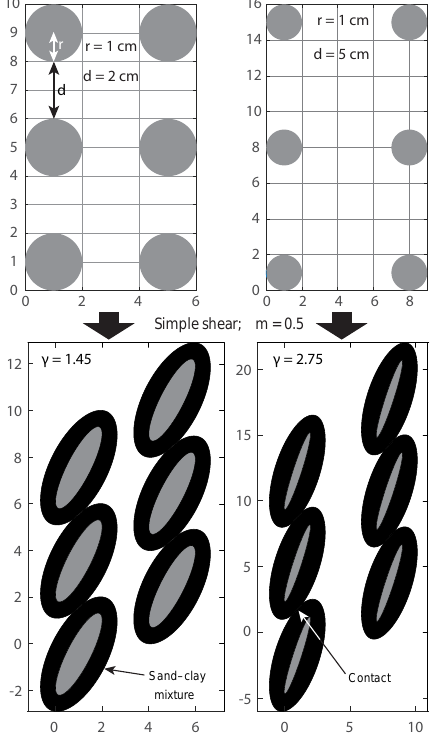
Figure B2. Example results of the mixing simulations for clay frag- ment with 1cm radius and distances between fragments of 2 and 5cm. Strain was increased until sand–clay mixtures surrounding the clay fragments touch. Initial packings are shown as well as the sheared models at maximum strain. Larger distances between frag- ments require higher strain at the same rate of mixing to connect via mixing.